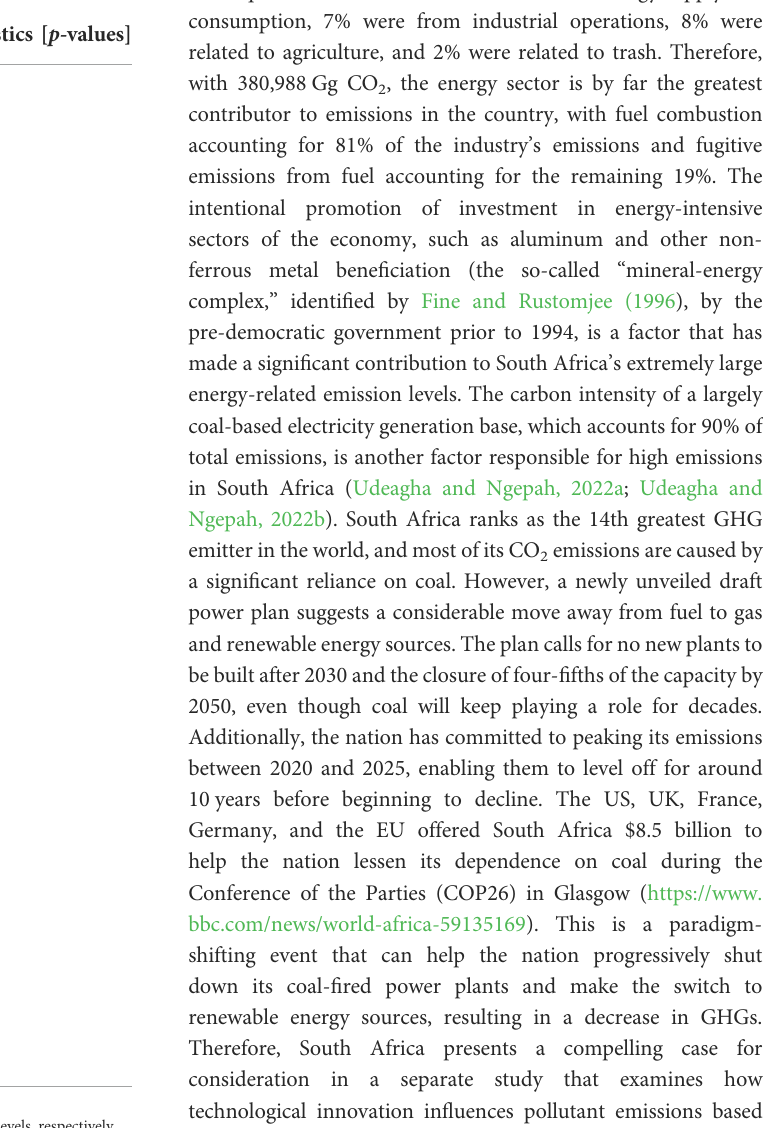
TABLE 7 Results of the Wald